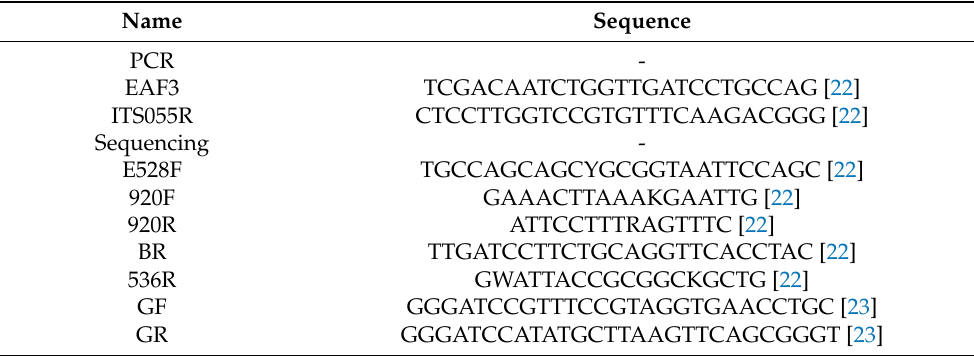
Table 1. Primers used for 18S rRNA gene amplification and